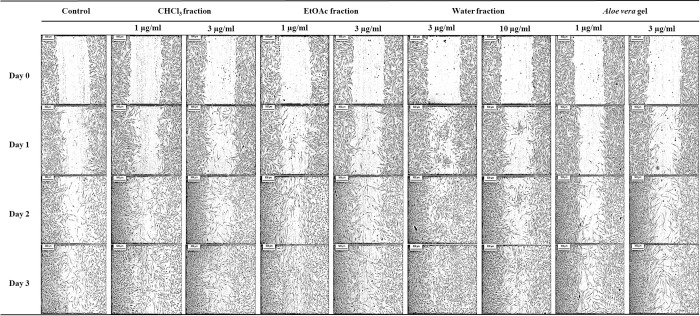
Effect of the CHCl3, EtOAc, water fractions and A. vera gel on HDF migration.Images were captured at day 0 and showed that an artificial wounded monolayer was created using the scratch assay. Then, treatments were applied with 1 and 3 μg/ml CHCl3 fraction, 1 and 3 μg/ml EtOAc fraction, 3 and 10 μg/ml water fraction, 1 and 3 μg/ml A. vera gel and control without treatment. Another set of images of fibroblast cell migration were captured at day 1, 2 and 3 after incubation. The cleared areas represented wound and shaded areas resulting in cell migration, which represents the wound closure.